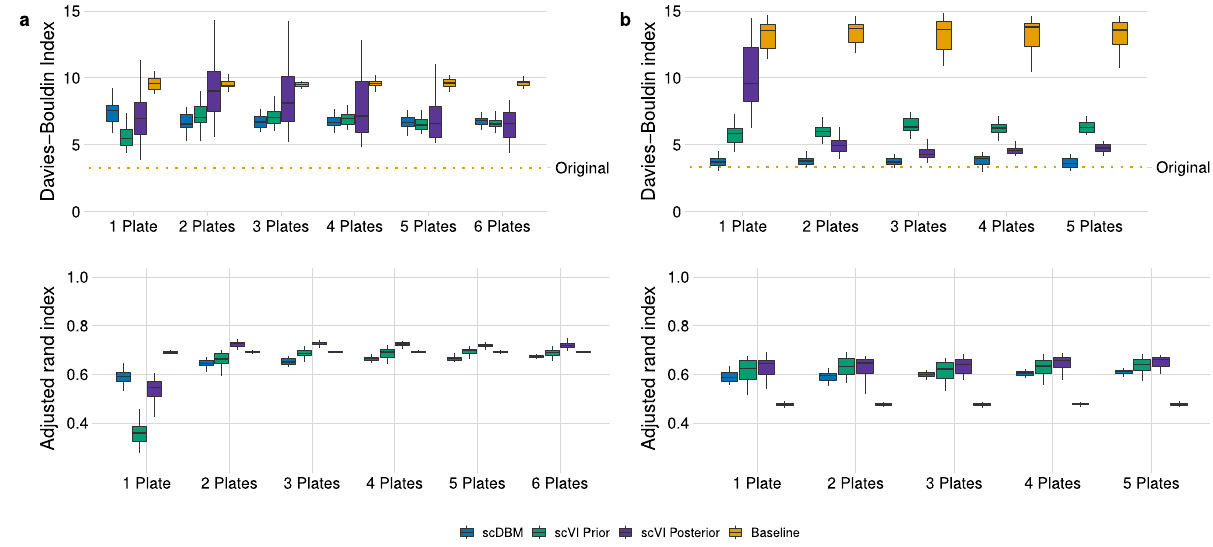
Figure 2. Davies-Bouldin index (top) and adjusted Rand index (bottom), indicating the quality of synthetic data generated by scDBM, scVI (prior and posterior sampling), and a baseline from pilot data of different sizes for PBMC 4 k ( a ) and Segerstolpe ( b ). Each boxplot represents 30 sub-samples from the original data (lower and upper hinges correspond to the 25th and 75th percentiles). The orange dotted line indicates the reference DBI for the Seurat clustering on the original